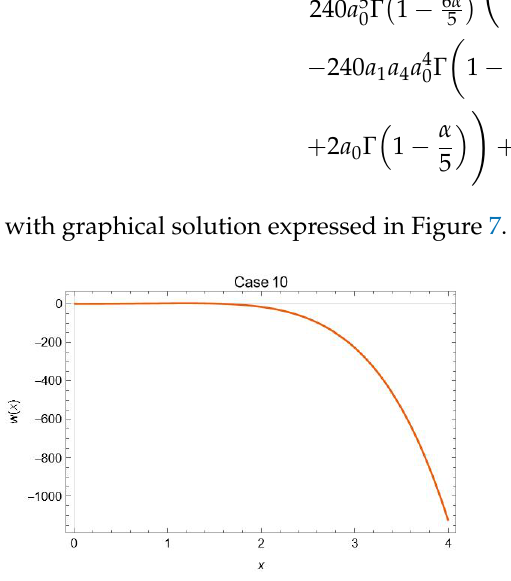
Figure 7. We let a 0 = 1, a 1 = 1, a 2 = 1, a 3 = 1, a 4 = 1, α = 1